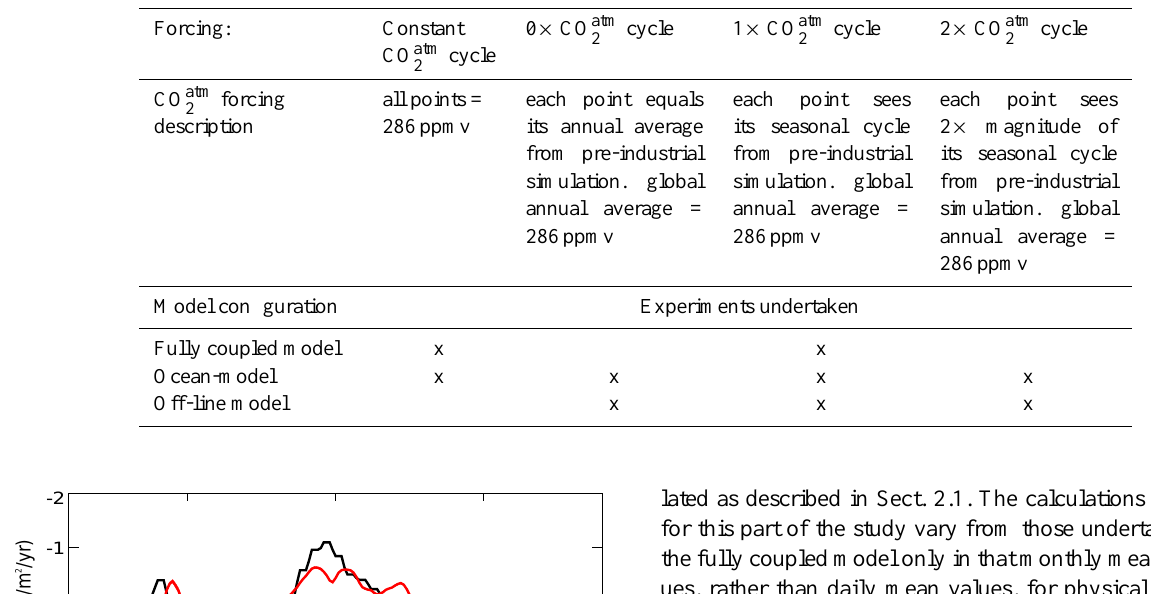
Table 1. Specification of different model configurations and matrix showing which experiments (i.e. which CO atm have been undertaken using each configuration.